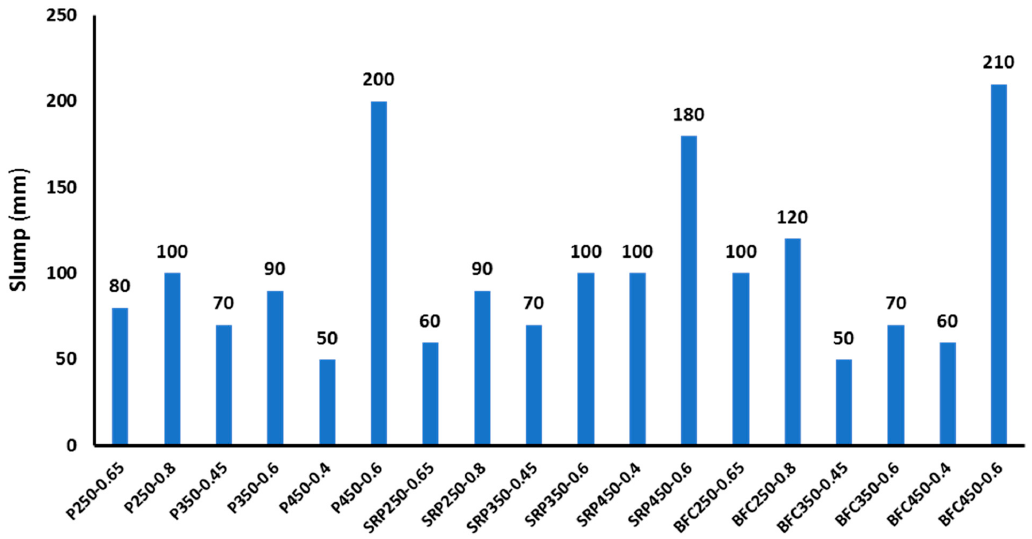
Figure 3. Experimental results of the slump test for all mixes.